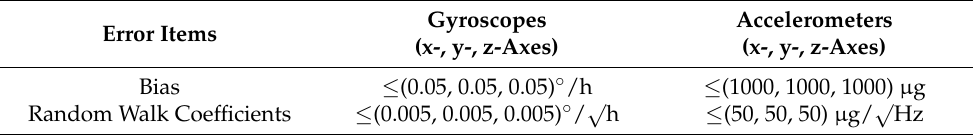
Figure 8. The in-motion status of the vehicle. Figure 9. The pitch errors. 0